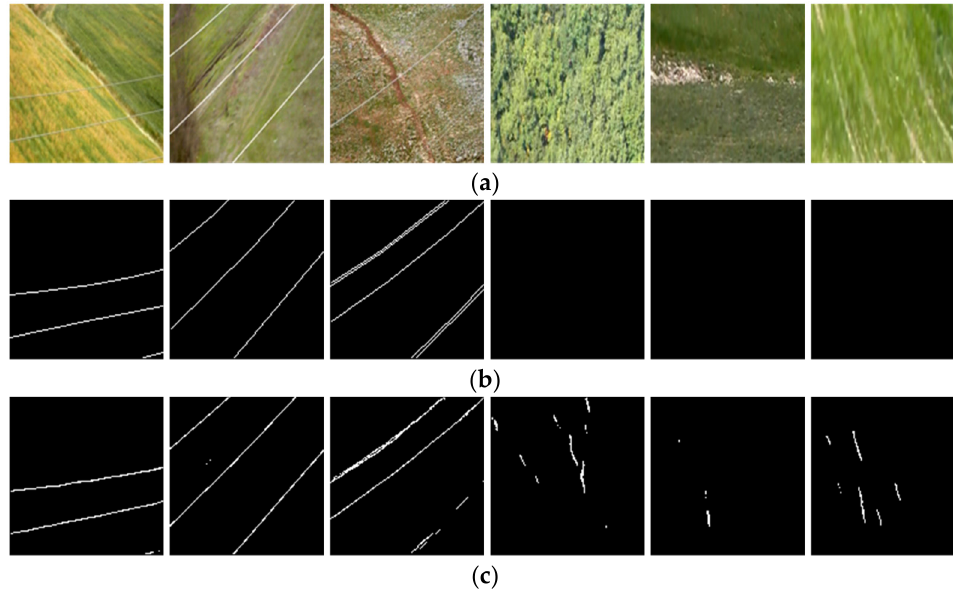
Figure 1. Results of traditional deep learning based PLE in practice. ( a ) Aerial images. ( b ) Ground Truth. ( c ) Extract results.